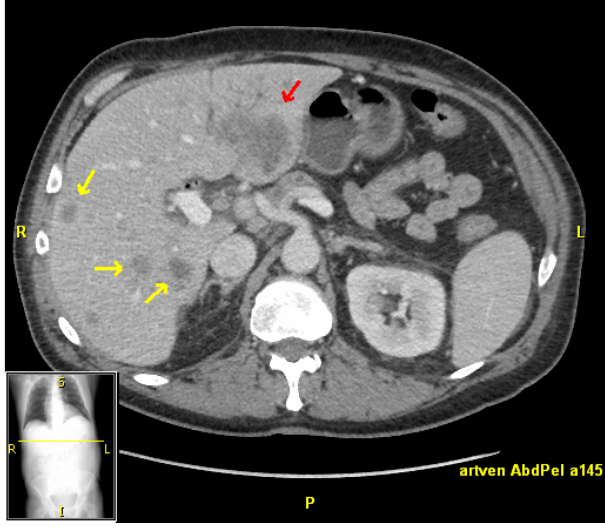
Figure 2. Metastatic pancreatic cancer. Multiple small liver metastases (yellow arrows) and a larger metastasis in the left lobe of the liver (red